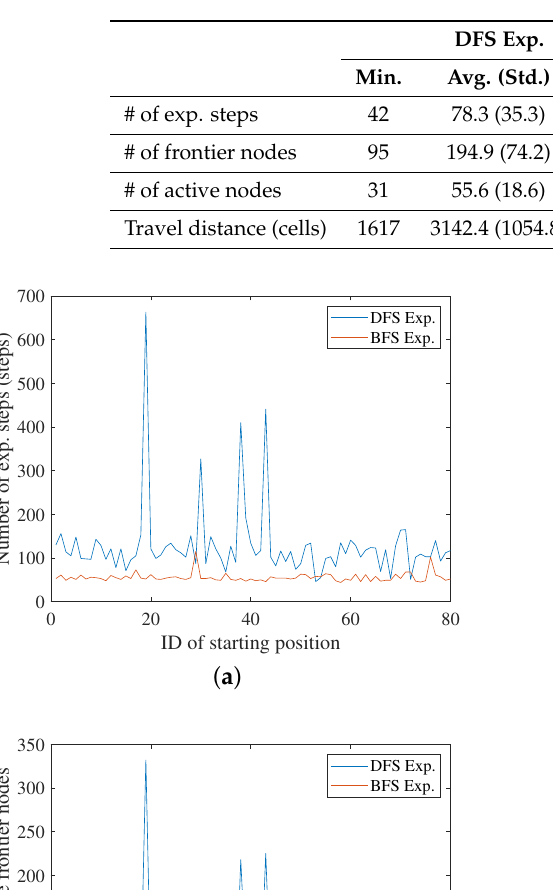
Table 4. Simulation results for 8 m LRF in Figure 7.